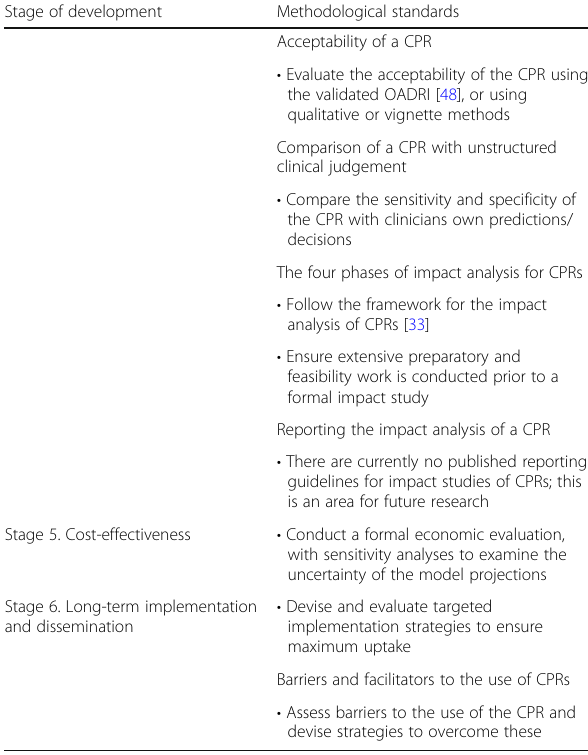
Table 1 Stages in the development and evaluation of clinical prediction rules (Continued)